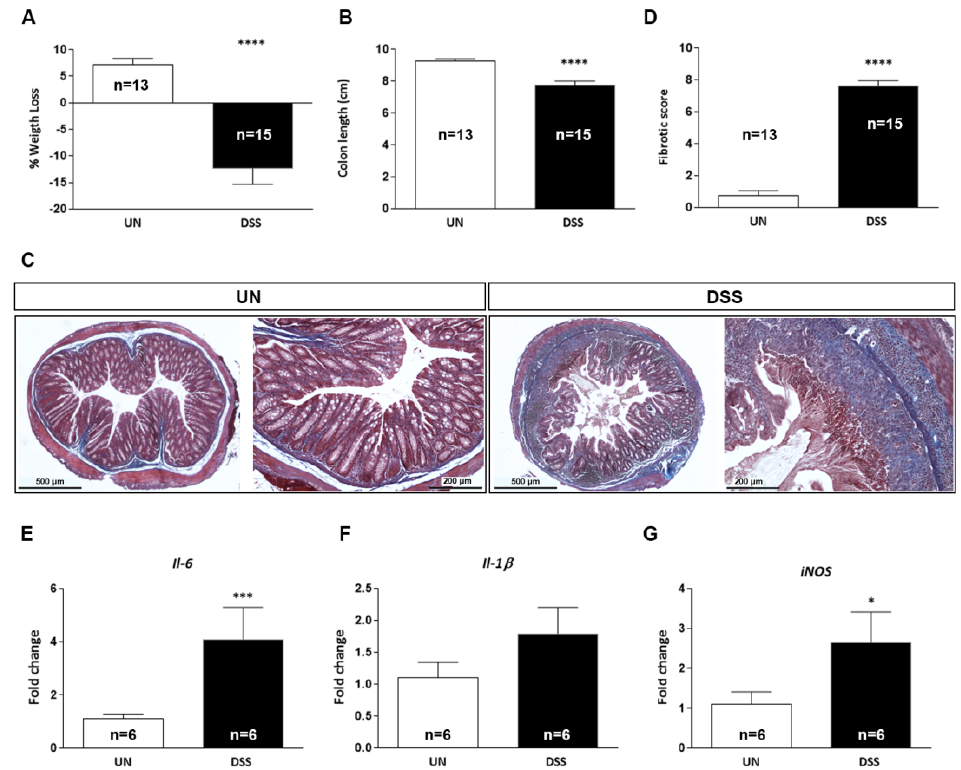
Figure 3. Macroscopic, molecular and histological analyses in the colon of C57BL/6 mice with DSS-induced chronic colitis. Following parameters were analyzed: body weight loss ( A ), colon length ( B ), Masson’s trichrome-stained sections of colon ( C ), fibrotic score ( D ). mRNA expression levels of proinflammatory cytokines ( E ) Il - 6 , ( F ) Il - 1 β and of the oxidative stress marker ( G ) iNOS were analyzed by qPCR. UN: untreated group; DSS: sodium dextran sulfate treated group. The number of mice used per test is indicated in the graphs (n). Data are reported as mean ± SEM, * p < 0.05; *** p < 0.001; **** p < 0.0001 for comparison with controls.